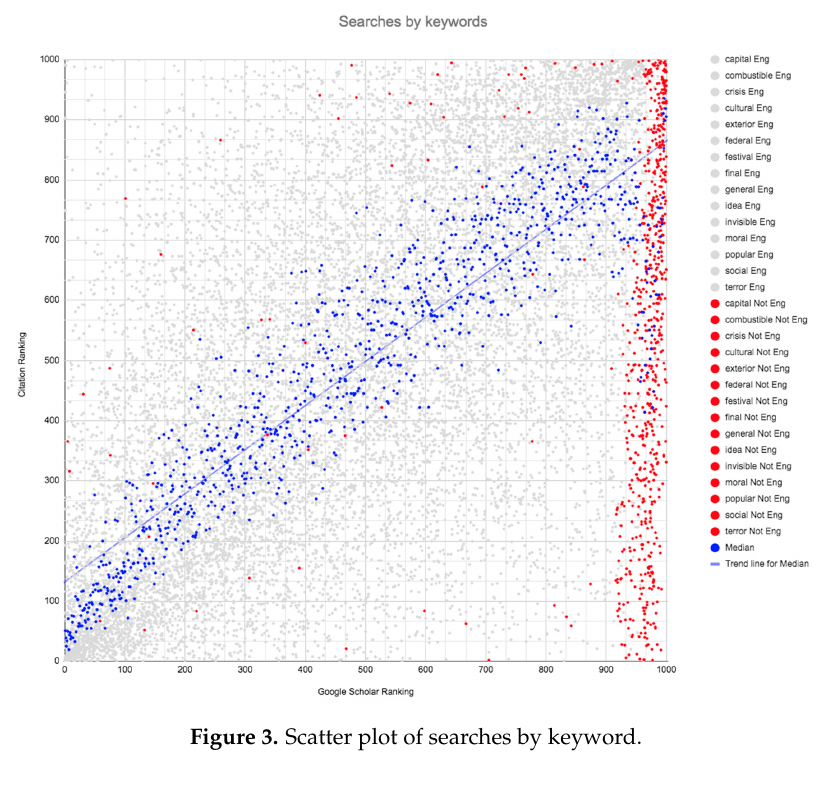
Figure 3. Scatter plot of searches by keyword.